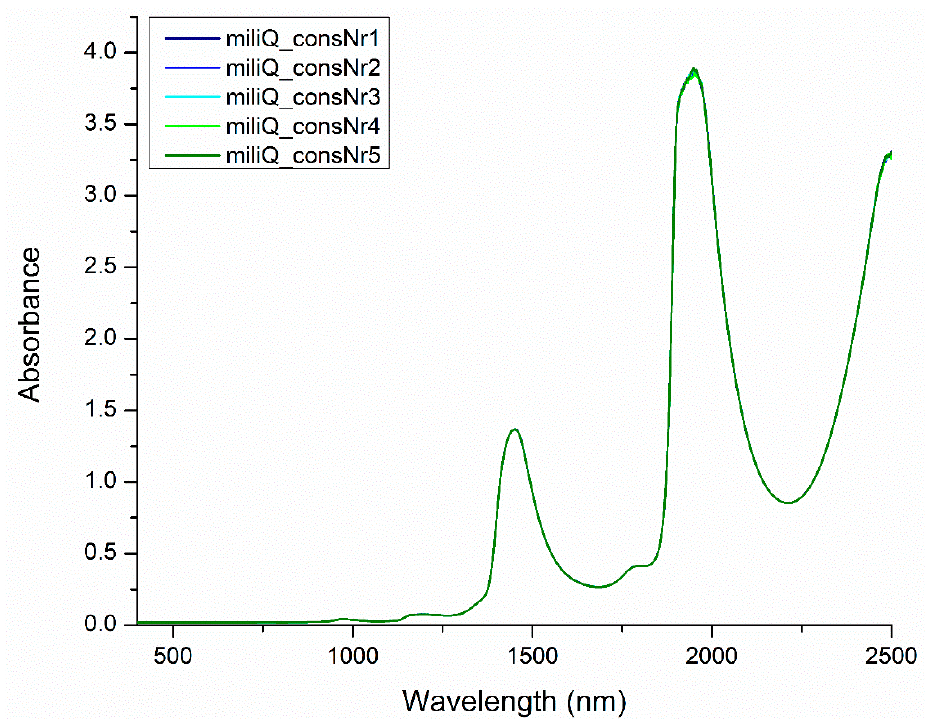
Figure 3. Spectra of pure water (produced by Milli-Q water purification system (Millipore, Molsheim, France) in the visible-near infrared region (400–2500 nm). Five spectra (miliQ_consNr1, miliQ_consNr2, miliQ_consNr5) presented in the figure were acquired by illuminating the same water sample five times consecutively.